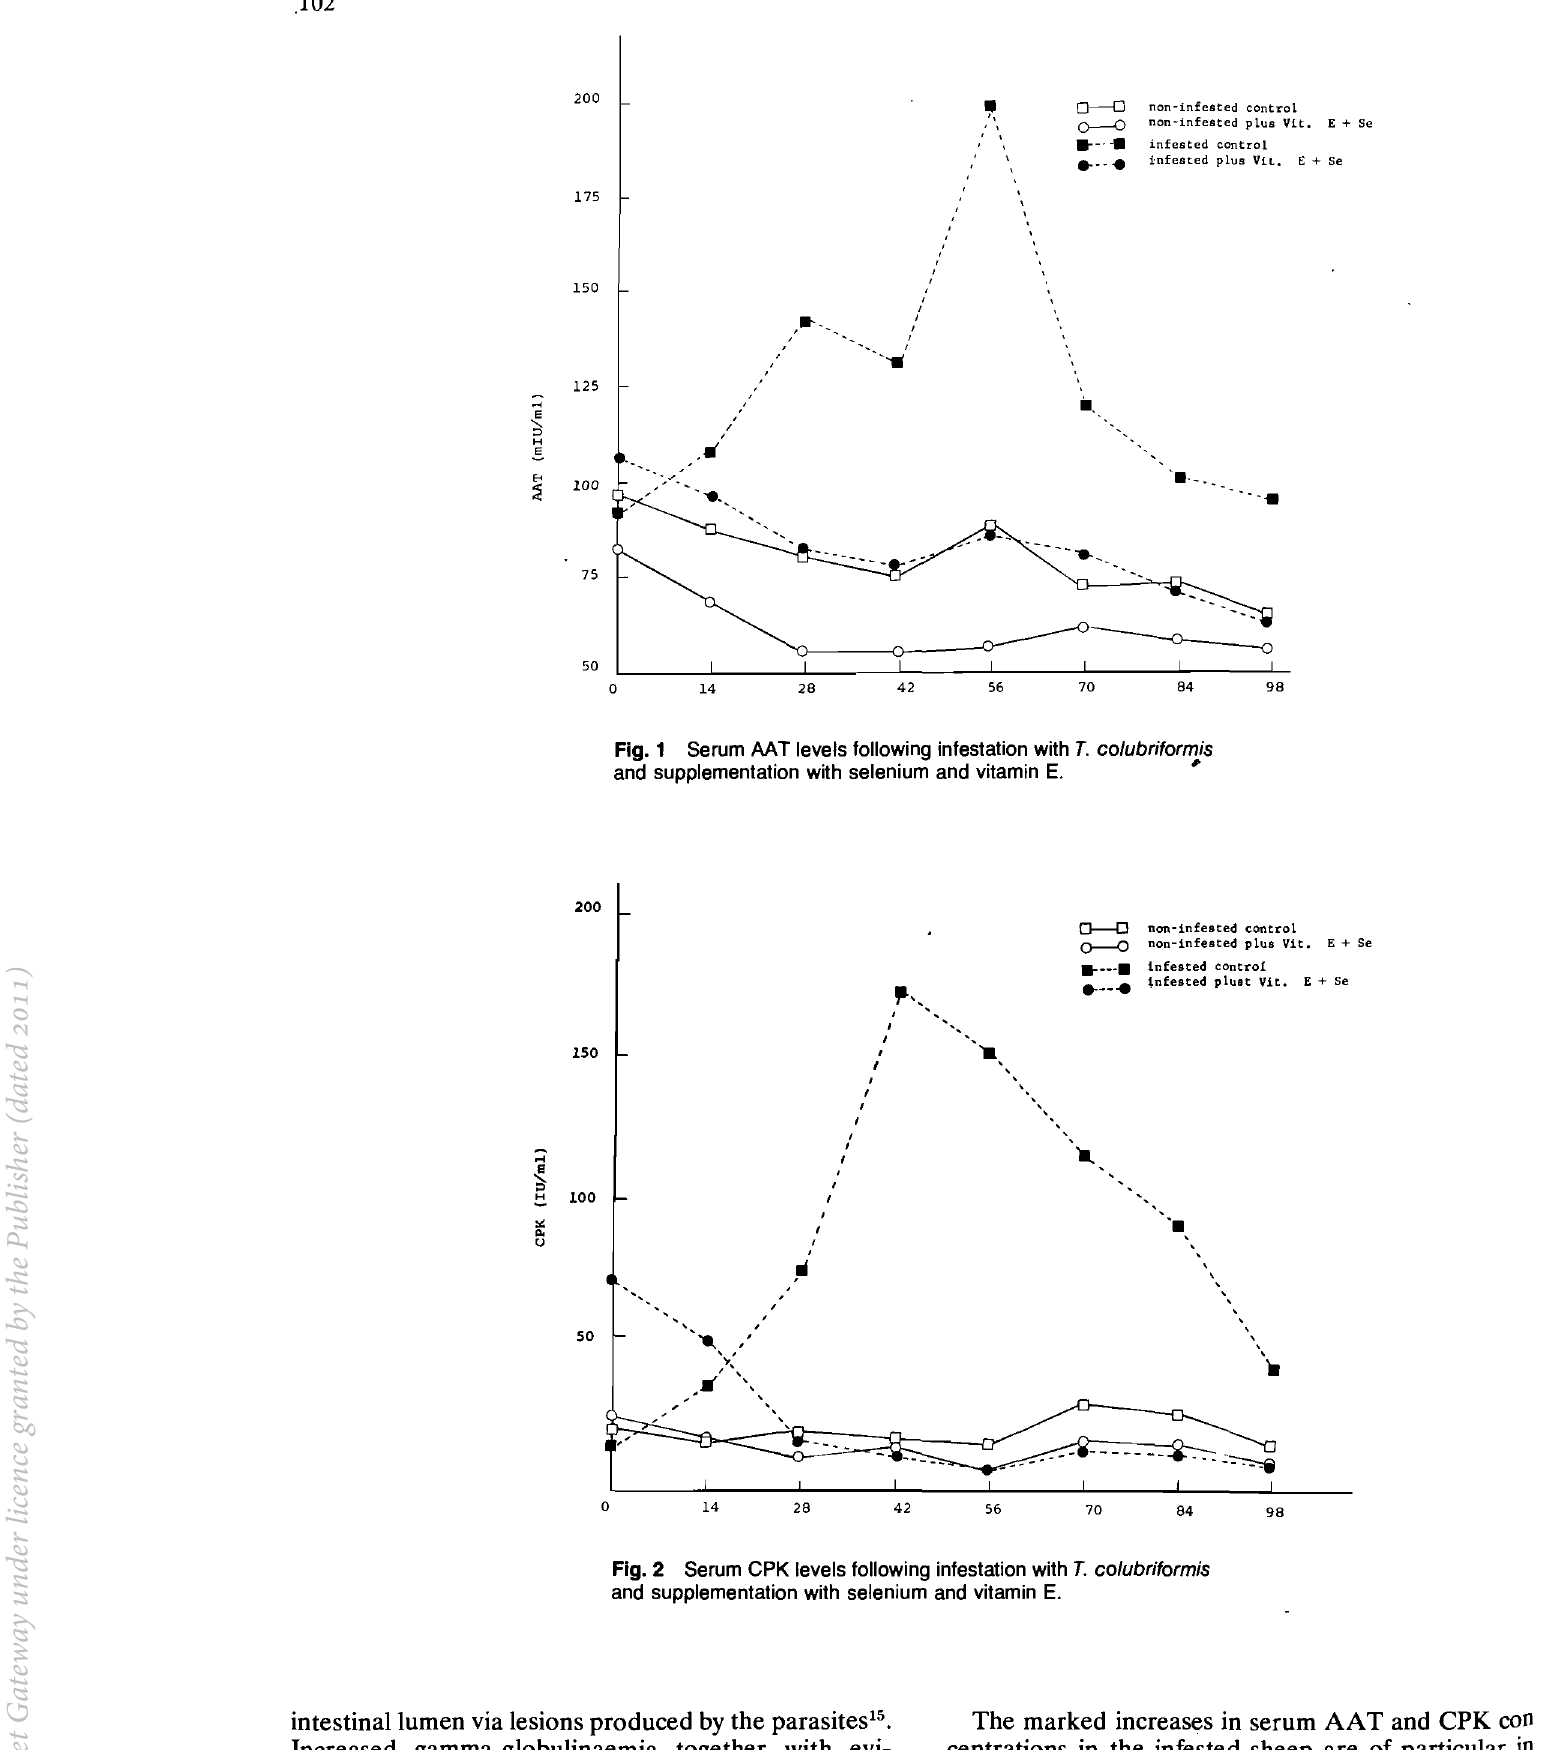
Fig. 2 Serum CPK levels following infestation with T. colubriformis and supplementation with selenium and vitamin